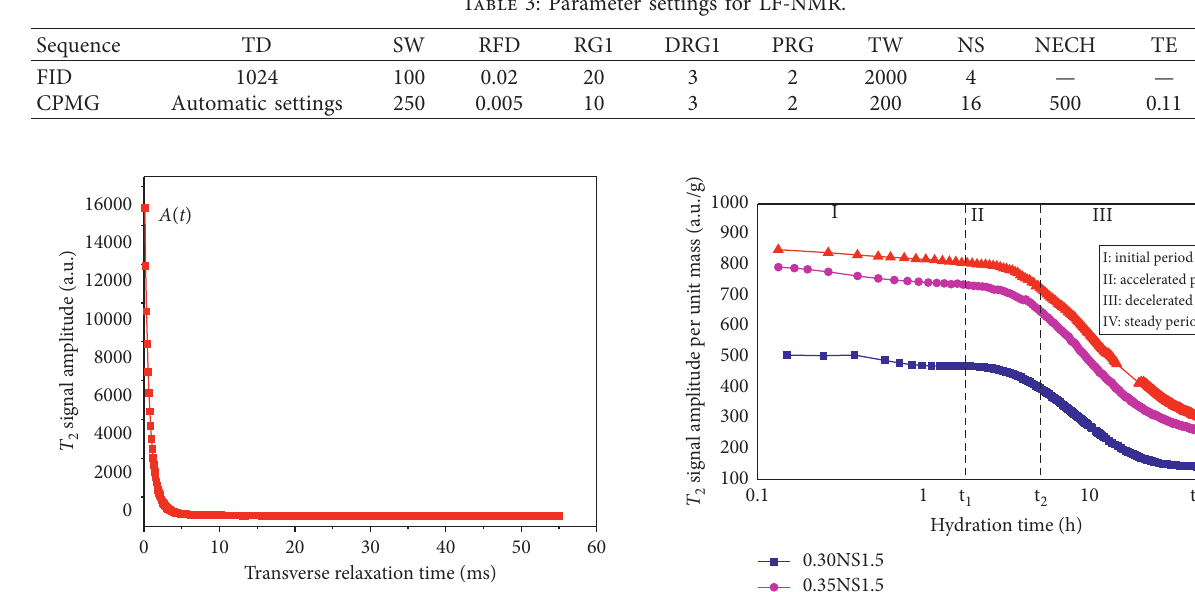
Figure 1: First wave crest amplitude of T